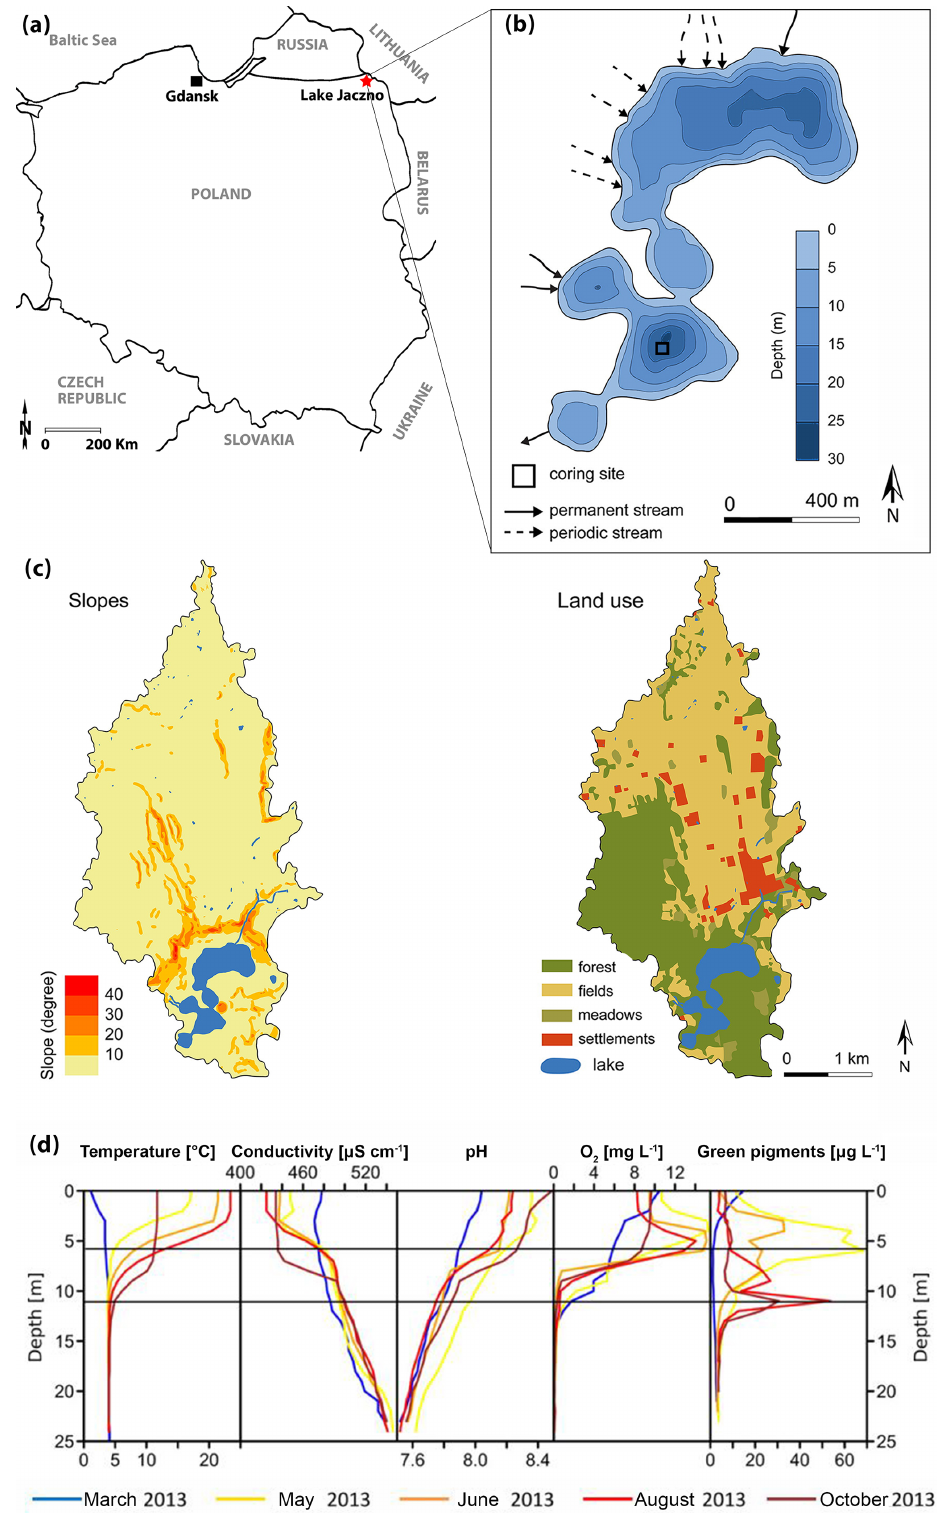
Figure 1. (a) Localization of Lake Jaczno. (b) Lake bathymetry (modified from Poraj-Górska et al., 2017) and coring position. (c) Slopes and land use maps of the catchment (modified from Poraj-Górska et al., 2017). (d) Seasonal limnological parameters in 2013CE (Butz et al.,